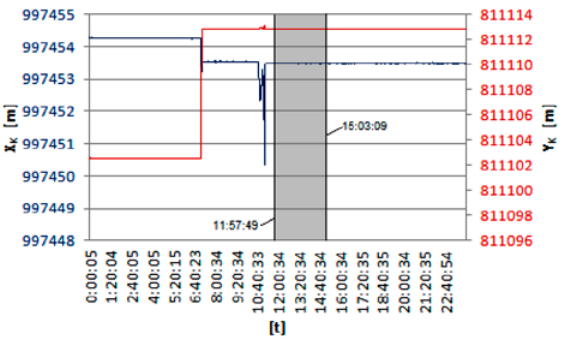
Fig. 7. Detail of wheel boom with Excavator Bucket Wheel. Centre of wheel (point